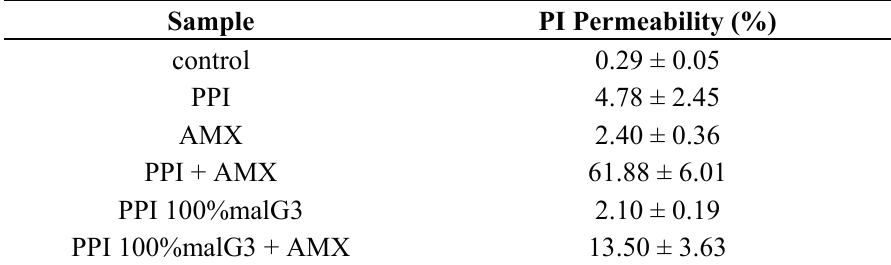
Figure 6. Permeability of cell membranes of P. aeruginosa after treatment with PPI dendrimers. Table 1. PI permeability (%) of cell membranes of P. aeruginosa after treatment with PPI